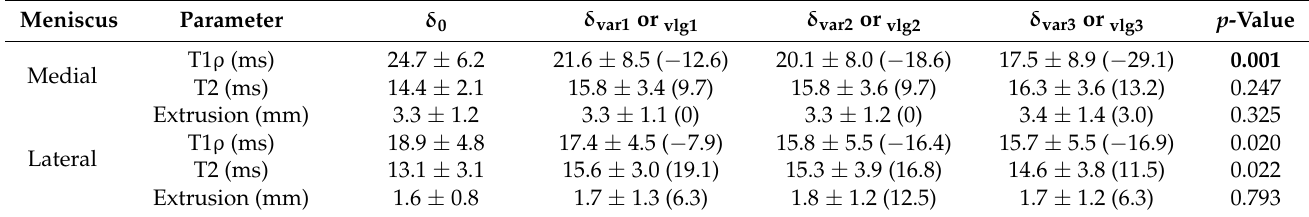
Table 5. Mean absolute T1 ρ and T2 relaxation times (ms) and meniscal extrusion (mm) of the medial and lateral meniscus body region in response to varus and valgus loading. Mean ± standard deviation (mean percentage change versus δ 0 (%)). Statistical analysis was performed using Friedman’s test for T1 ρ and T2 and repeated measures ANOVA for meniscal extrusion. Statistically significant results are indicated by bold type . Please refer to Table 2 for additional details on table organization.